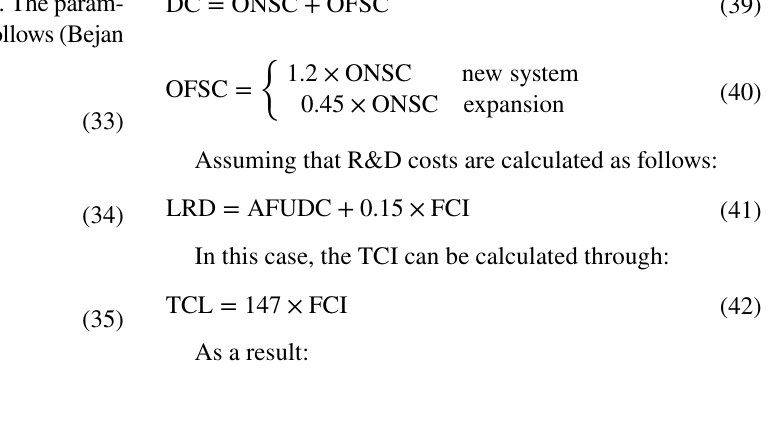
exergies in each section (Tajik Mansouri et al. 2020; Bejan et al. 1995)